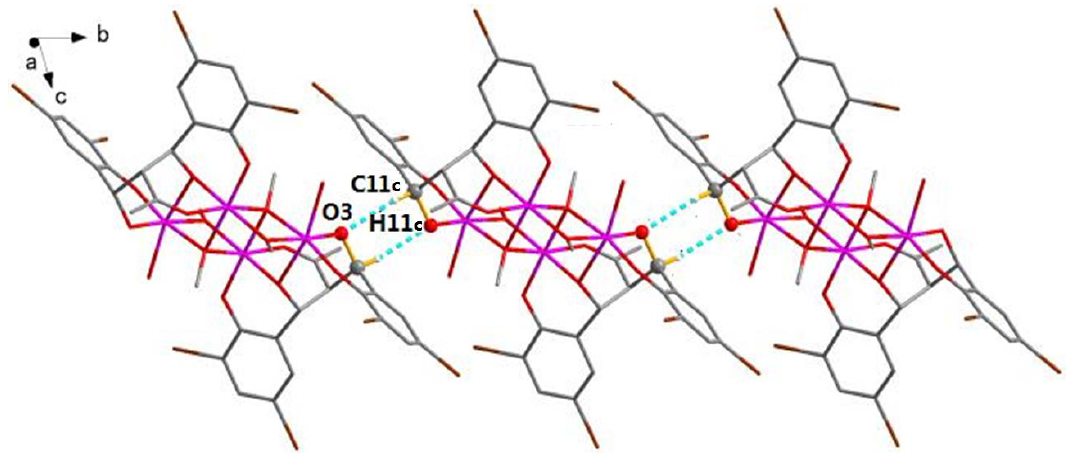
Figure 12. Part of 1D supramolecular structure containing C11c–H11c···O3 hydrogen bond interactions along the b axis in complex 3 (symmetry codes: c = 1 − x, 2 − y, 1 − z).